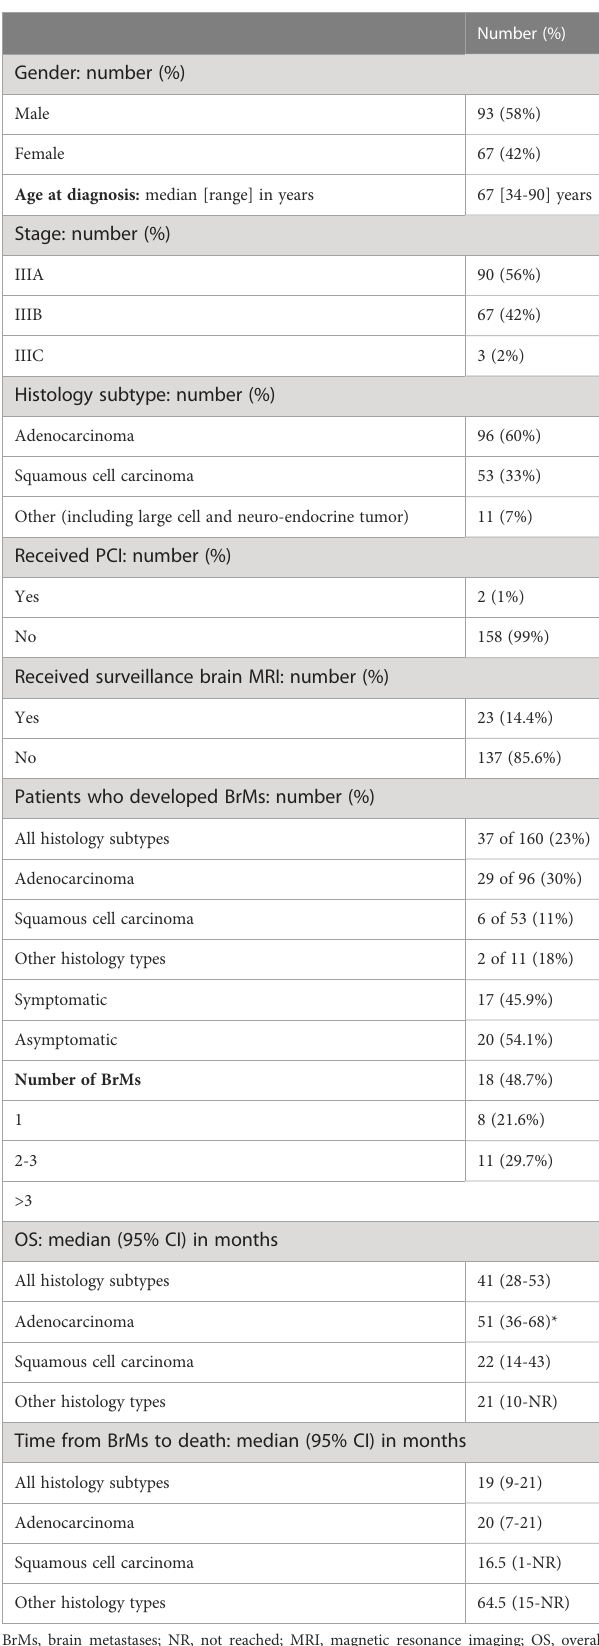
TABLE 1 Demographic and baseline characteristics of included stage III NSCLC